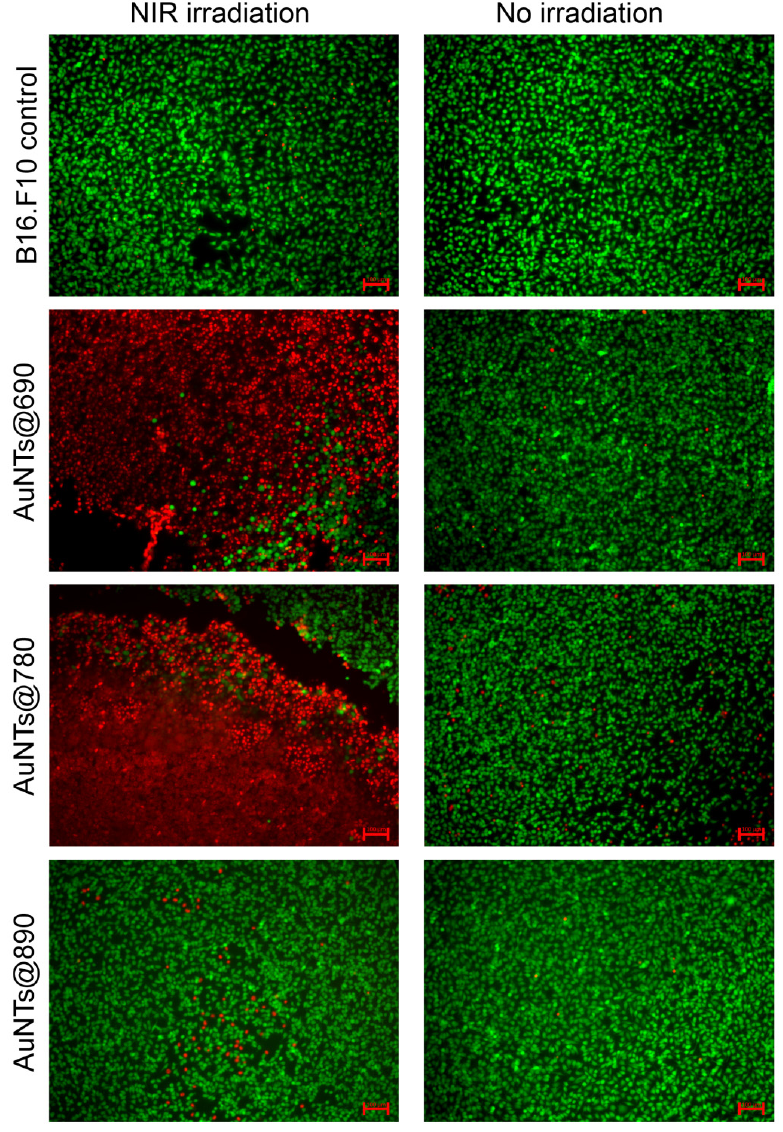
Figure 7. Merged fluorescence images of B16.F10 cells stained with calcein-AM and PI before and after NIR irradiation. The scale bars represent 100 µ m.